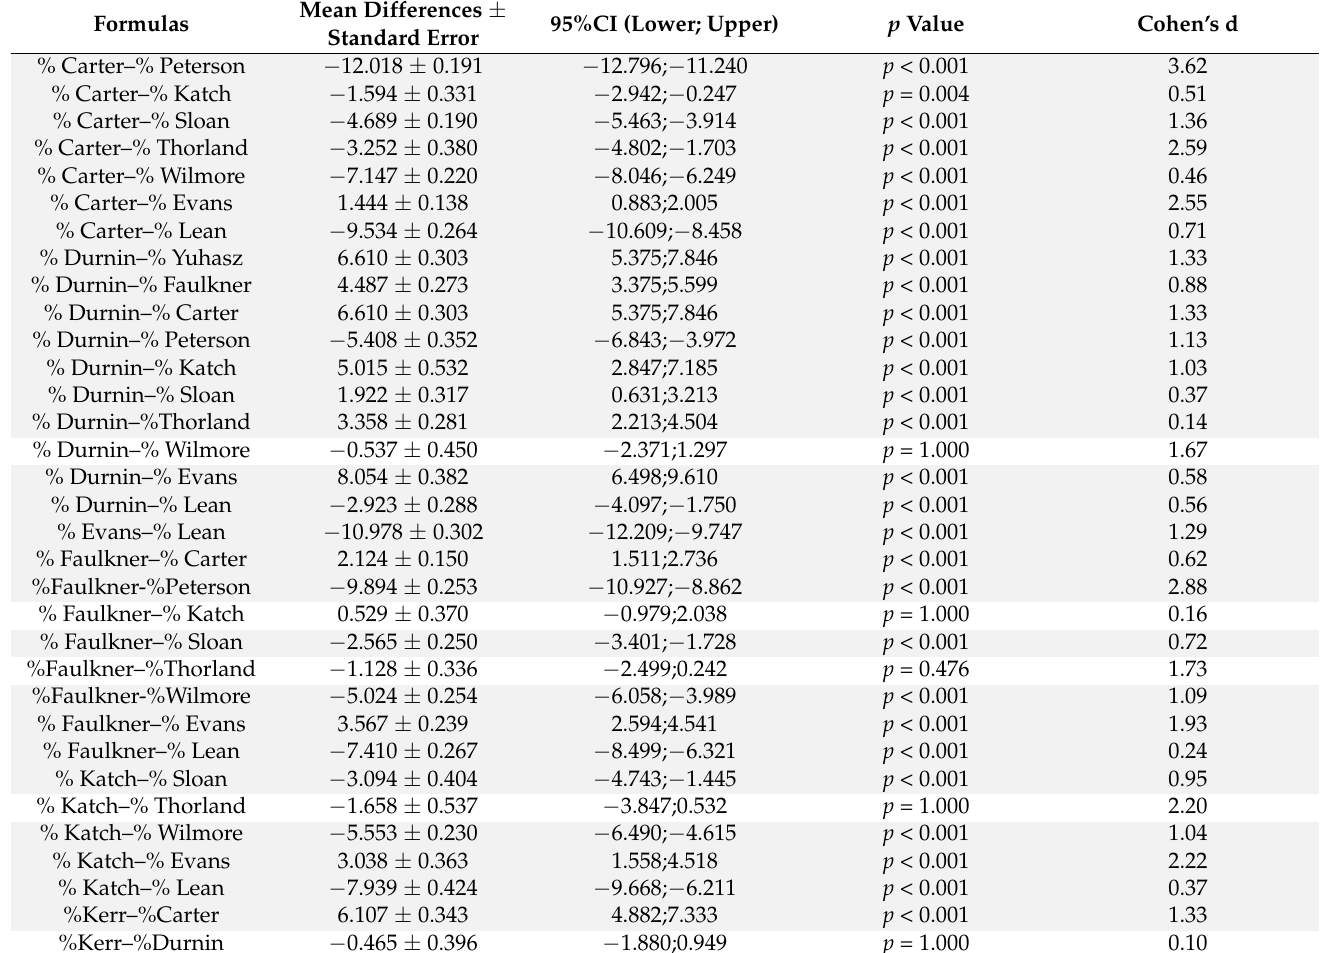
Table 4. Differences between lipid formulas in mean of percentages in